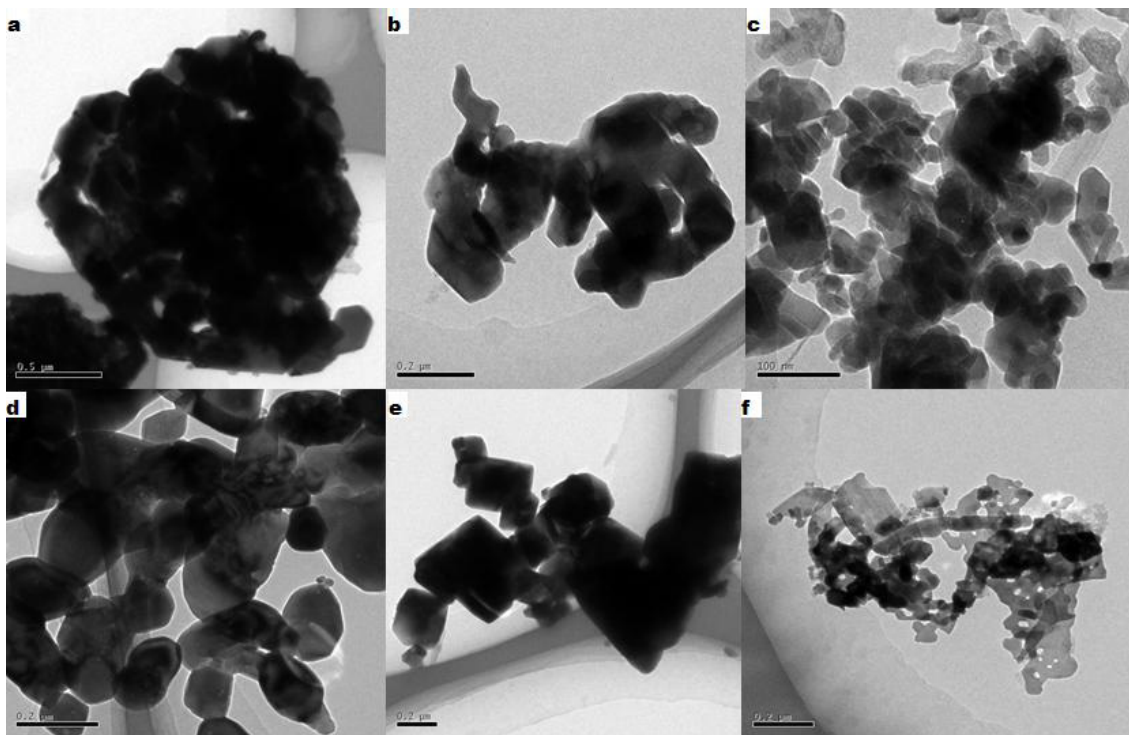
Figure 3: TEM images of the Co3O4 prepared by co-precipitation method: (a-c) Co3O4 prepared sample before calcinations, (d-f) Co3O4 after calcination.